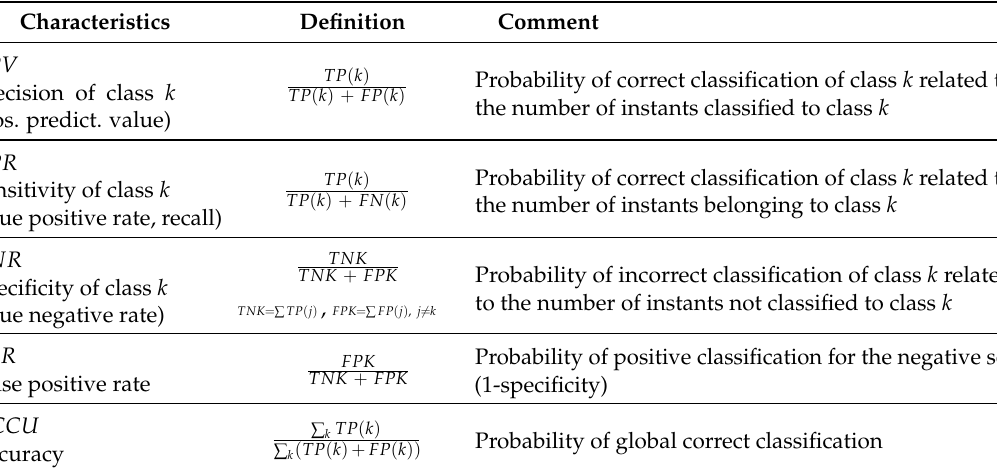
Table 3. Common performance metrics of the confusion matrix for the multi-class